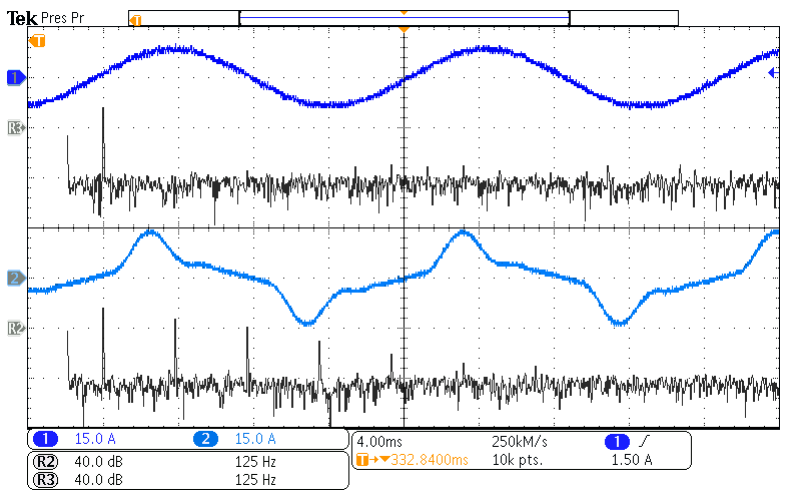
Figure 17. Steady state responses of: (CH1) the grid current i G (y-axis 15 A/div, x-axis 4 ms/div); (R2) the frequency spectra of i G (y-axis 40 dB/div, x-axis 125 Hz/div); (CH2) the current consumed by the NLL i NLL (y-axis 15 A/div, x-axis 4 ms/div); and (R3) the frequency spectra of i NLL (y-axis 40 dB/div, x-axis 125